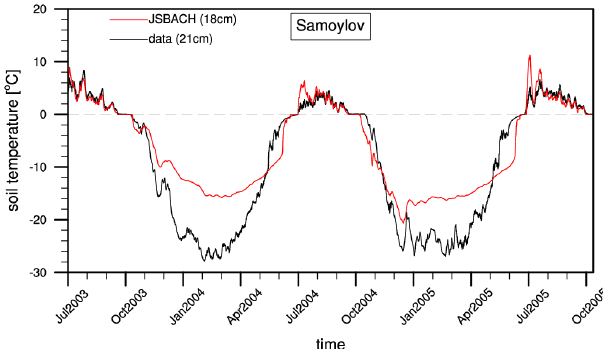
Fig. 5. Observed and simulated soil temperature at the Samoylov site. Observed soil temperature at 21cm is plotted with the black line and the red line shows the JSBACH-simulated soil temperature in the second layer (ca. 18cm).